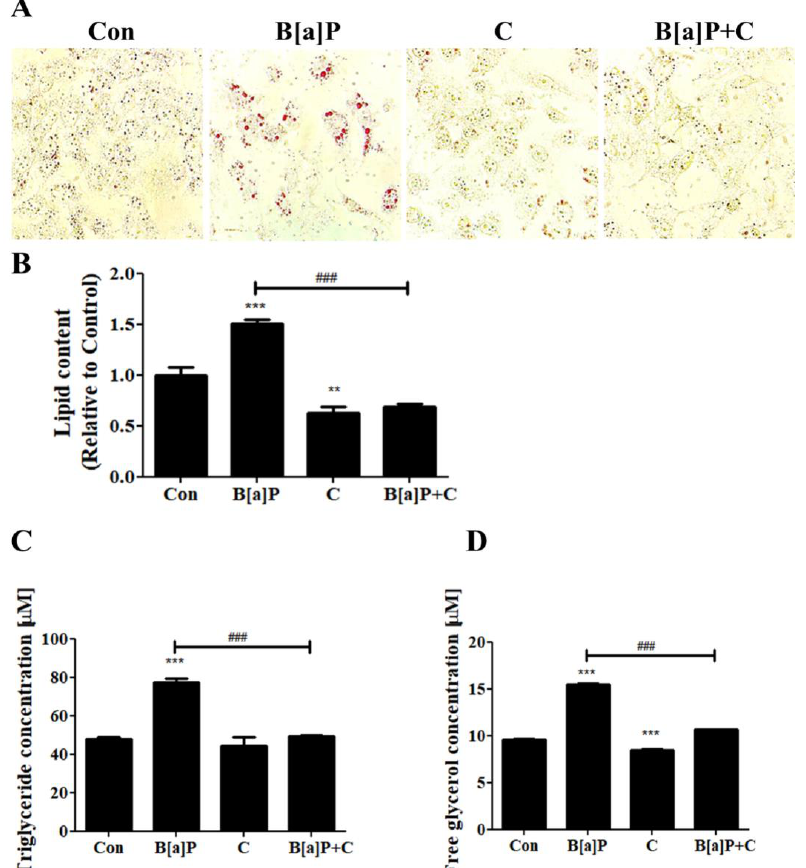
Figure 2. Suppressive effect of curcumin on the lipid accumulation induced by B[a]P. ( A ) Inhibitory effect of curcumin on the B[a]P-induced accumulation of lipid droplets (stained with oil red O). N = 5 trials per sample and control. ( B ) Stained lipids were dissolved and quantified. Curcumin-induced attenuation of the increase in the triglyceride ( C ) and free-glycerol ( D ) levels in the cell-culture media. N = 3 trials per sample and control. ** p < 0.01 and *** p < 0.001, compared with the control; ### p < 0.001, compared with the B[a]P-treated group. Con: control; B[a]P: benzo[a]pyrene (10 µM); C: curcumin (10 µM).